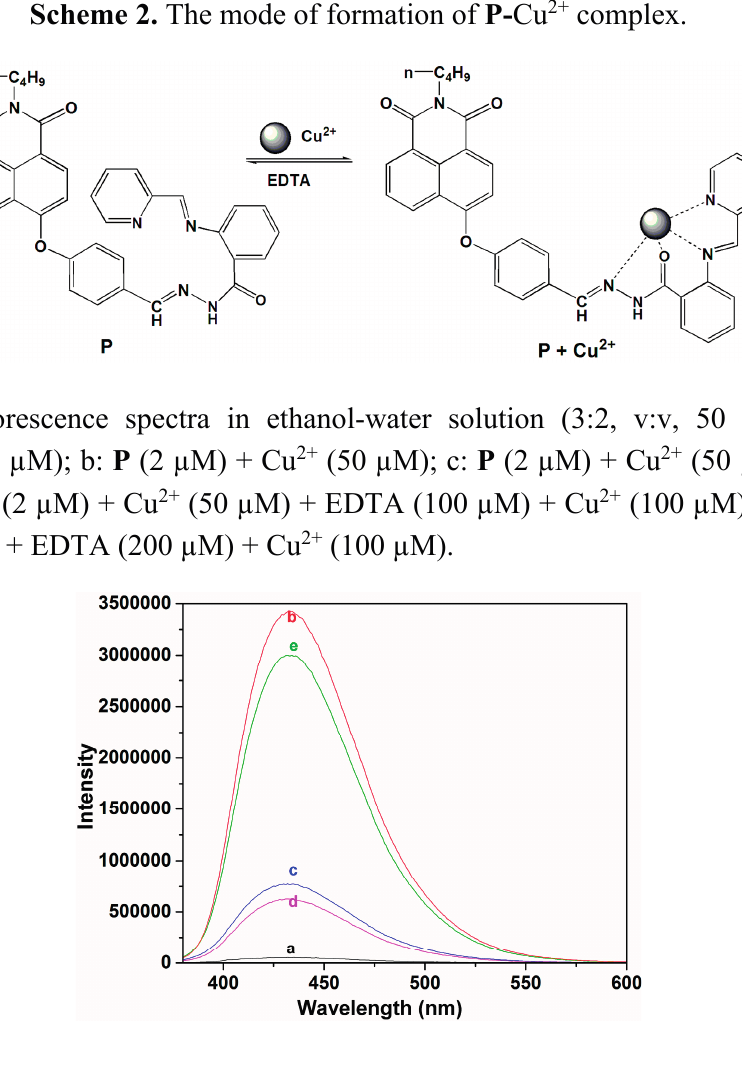
Scheme 2. The mode of formation of P- Cu 2+ complex.